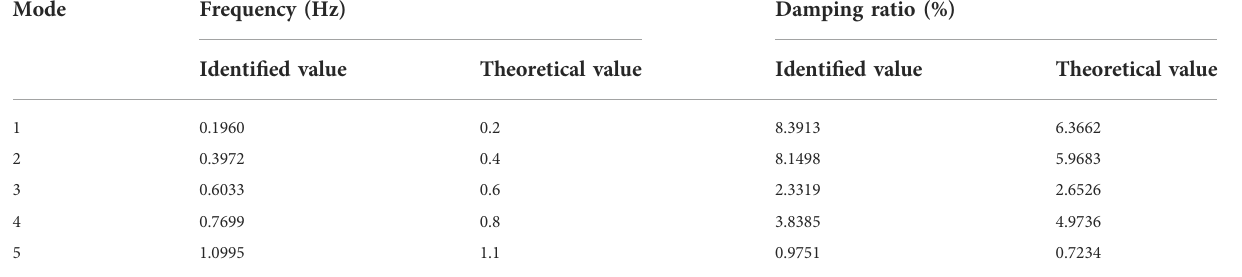
TABLE 1 Extracted modal parameters of test